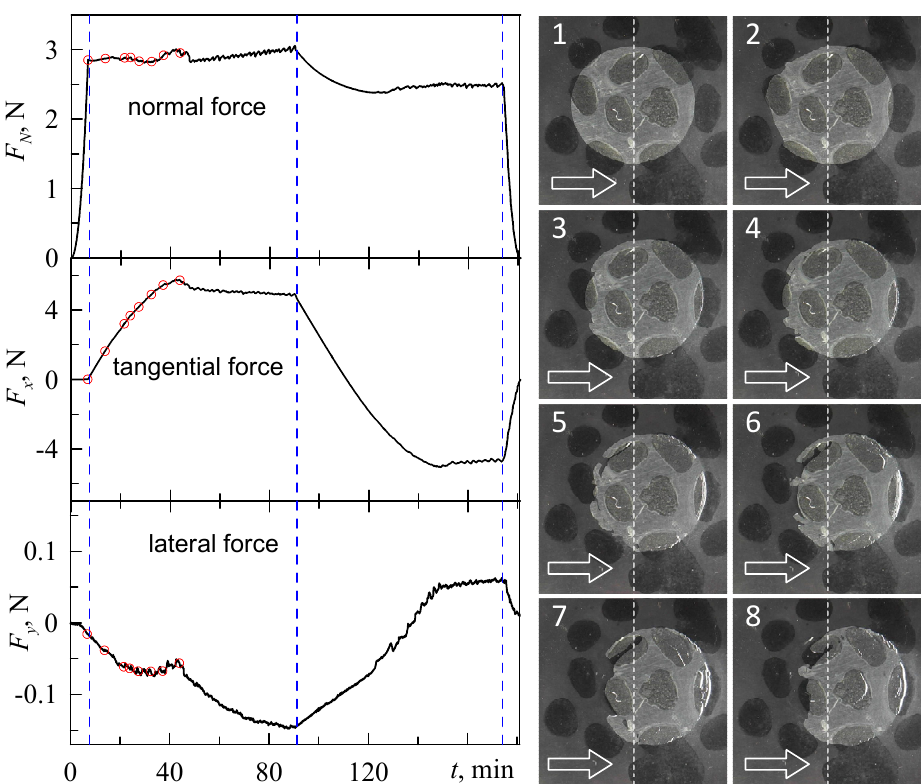
Figure 9. Time dependencies of all three components of the contact force (( left ) panels) and related images of the contact area (( right ) panels). Chemical inhomogeneities on the surface of the indenter in the ( right ) panel are pictured as dark spots. 8 red dots on the curves ( left panel) show the time moments when the snapshots ( right panel) were taken. Increasing numbers of the snapshots relate to growth of both tangential shift of the indenter and time from the start of the experiment.